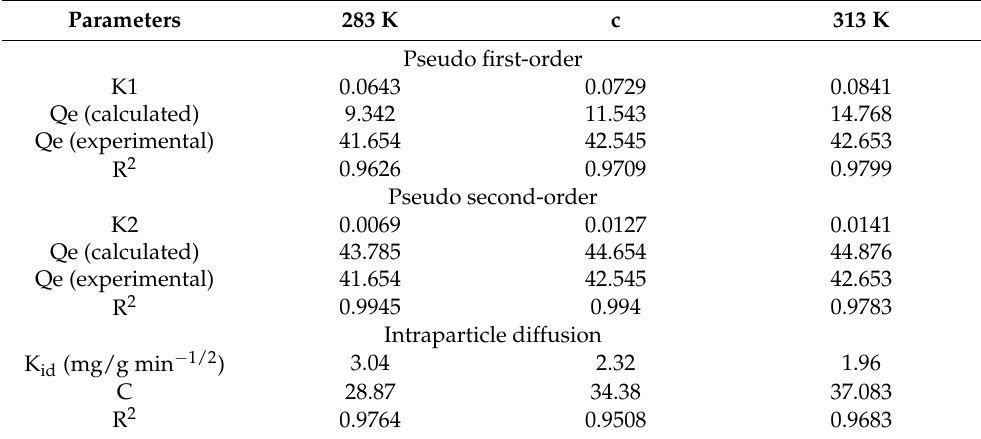
Table 2. Different kinetic models’ parameters for the adsorption of AB-234 dye on